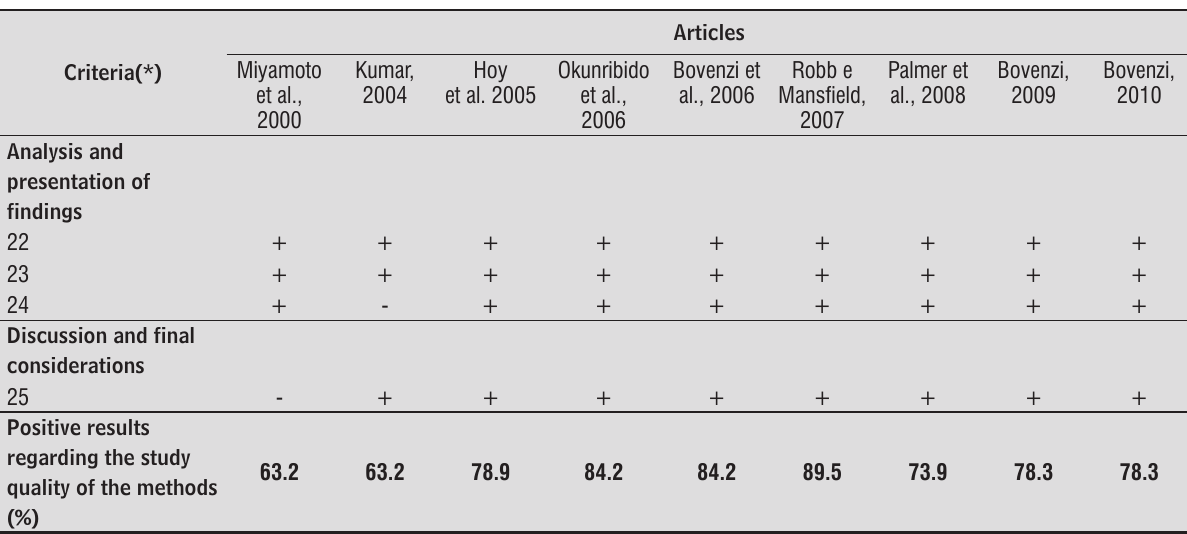
Table 2 - Standardized checklist of methodological quality of the cross-sectional (CS), case-control (CC) and cohort (CO)